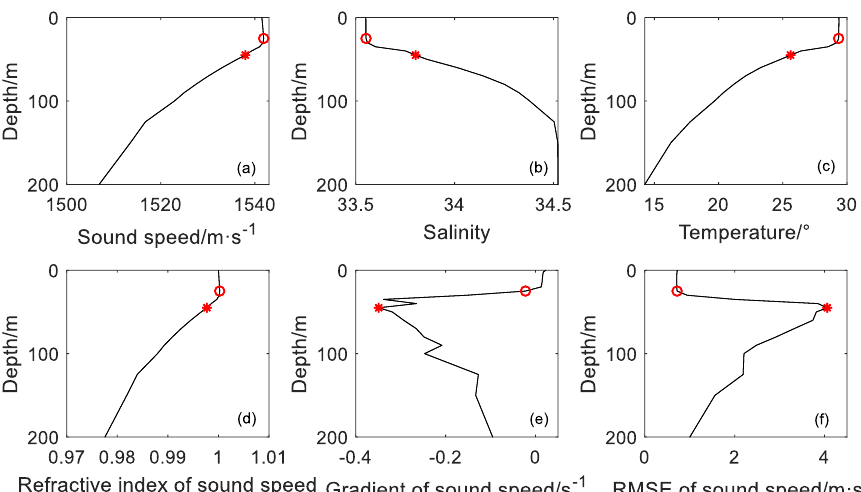
Figure 12. Parameters obtained for depths above 200 m. ( a ) Average sound speed, ( b ) salinity, ( c ) temperature, ( d ) refractive index of sound speed, ( e ) sound speed gradient, and ( f ) RMSE of sound speed. The circle indicates the depth of the maximum sound speed in the mixed layer, and the asterisk represents the depth of the maximum sound speed gradient.